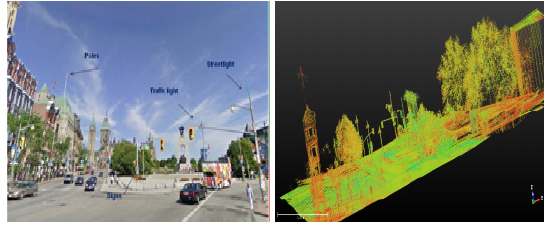
Figure 2. Part of Elgin Street, Ottawa. Left: Google maps (street view). Right: 3D point